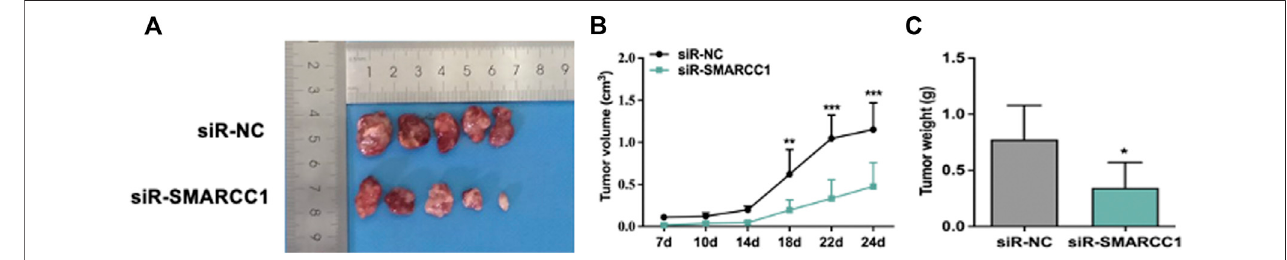
FIGURE 6 | SMARCC1 promoted tumor growth of BC. UMUC-3 cells infected with siR-NC or siR-SMARCC1 were subcutaneously injected into nude mice. The tumors were harvested and photographed (A) on day 24. Data for tumor volume (B) and tumor weight (C) were shown as the mean ± SD ( n = 5). Each siR-SMARCC1 group was compared with siR-NC group. * p < 0.05, ** p < 0.01, *** p <